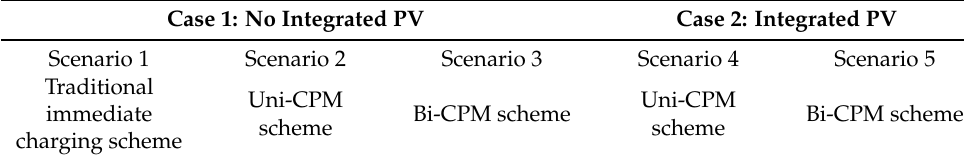
Table 1. Simulation cases and